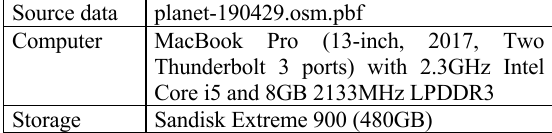
Table 1. Specification for the production time measurement